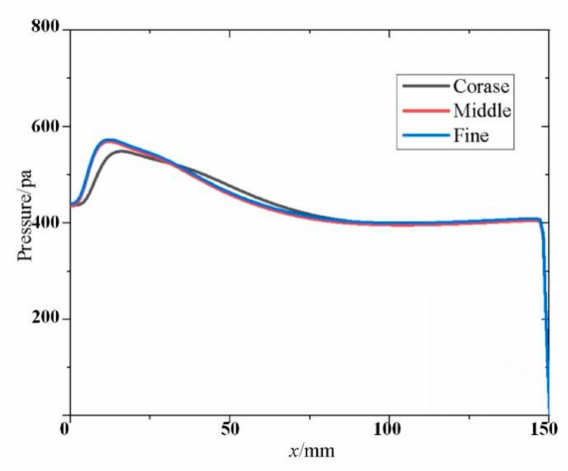
Figure 4. Curves comparing the accuracy with different numbers of grids.